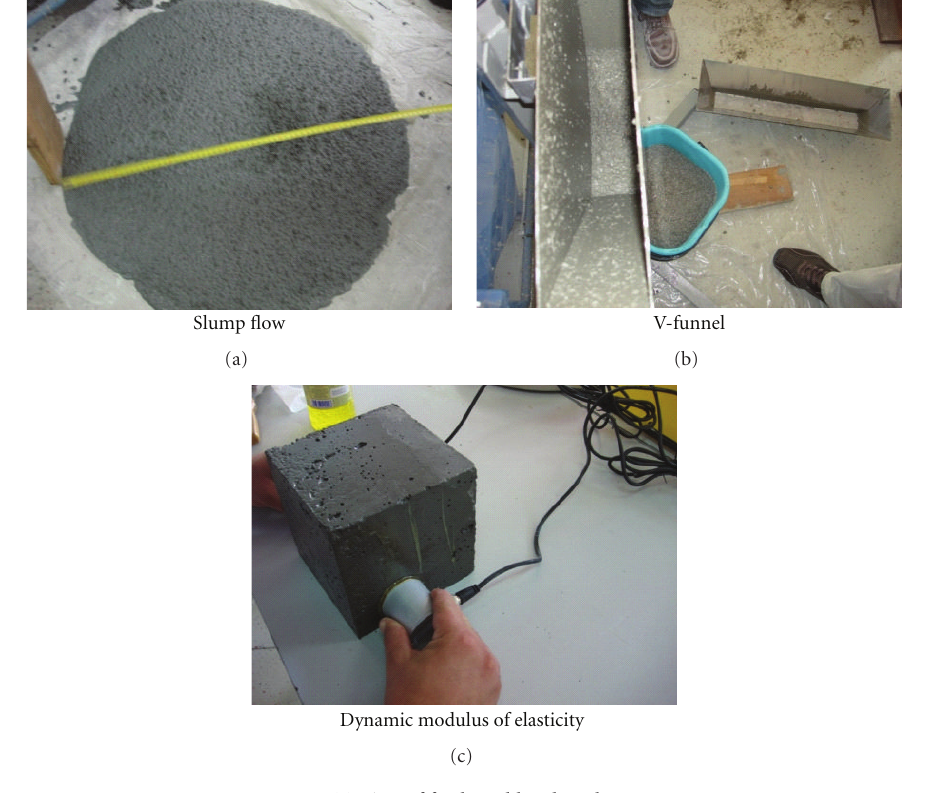
Figure 2: Testing of fresh and hardened concrete.